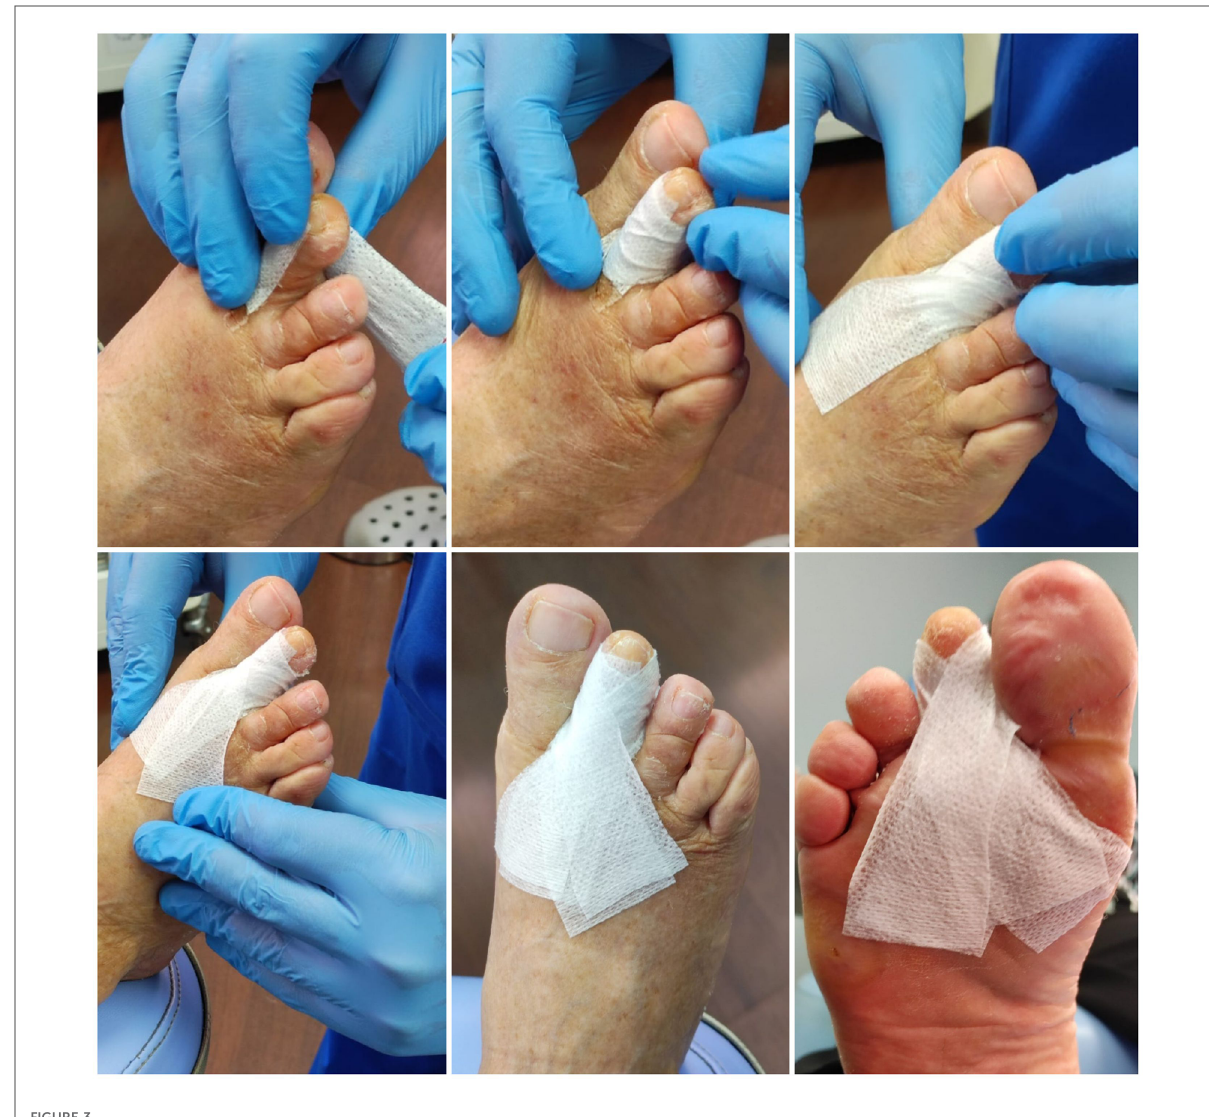
FIGURE 3 Post-surgical dressing, weekly